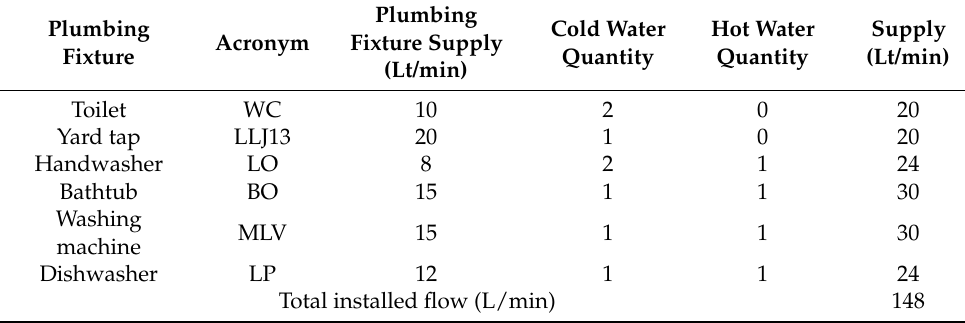
Figure 8. Insertion of the information for the pipes in an MS Excel ® spreadsheet using scripts 5 and 6. Table 7. System flow rates table for a single-family house.